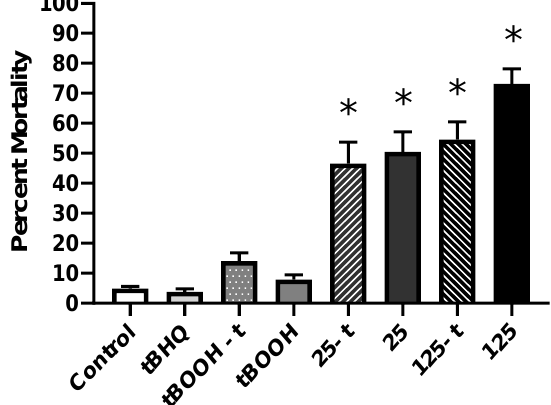
Figure 5. Mean ( ± SE) percent cumulative mortality (1–5 dpf) of zebrafish exposed via embryo aqueous exposure to facility water (control), tBHQ, tBOOH, and two concentrations of SeMet (25 and 125 µ g Se / L) either with (tBOOH-t, 25-t, 125-t) or without (tBOOH, 25, 125) a tBHQ pre-treatment. Asterisks represent significant di ff erences compared to the control using a Kruskal–Wallis one-way analysis of variance (ANOVA) by ranks followed by a Dunn’s multiple comparisons test ( p < 0.05); n = 20–33 replicates of 20